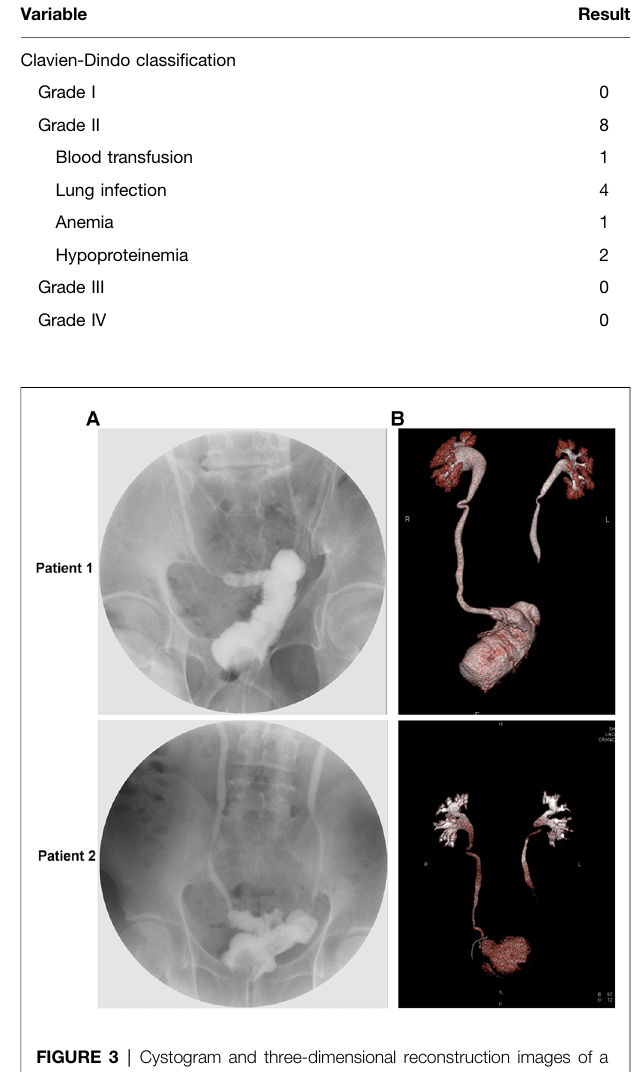
FIGURE 3 | Cystogram and three-dimensional reconstruction images of a representative postoperative Y-shaped neobladder. ( A ) Postoperative cystogram image. ( B ) Postoperative three-dimensional reconstruction